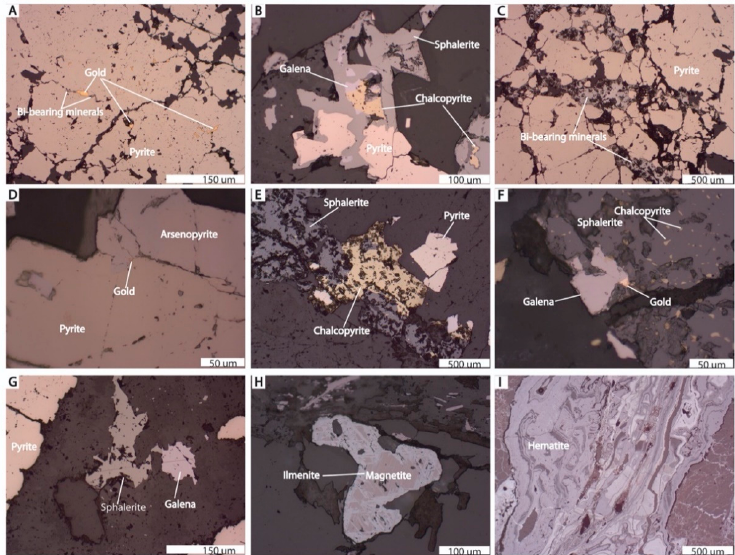
Figure 9. Reflected light microscopy images of sulfides from the veins. ( A ) Bi-bearing minerals and gold are filling fractures in pyrite; ( B ) Pyrite has an intergrown texture with galena, chalcopyrite, and sphalerite; ( C ) Bi-bearing minerals are filling cavity in pyrite; ( D ) Native gold occurs in the grain boundaries between pyrite and arsenopyrite; ( E ) Sphalerite, chalcopyrite, and pyrite; ( F ) Chalcopyrite in exsolution texture in sphalerite; ( G ) Pyrite, sphalerite, and galena; ( H ) Magnetite and ilmenite in transitional zone; (I) Hematite in oxide